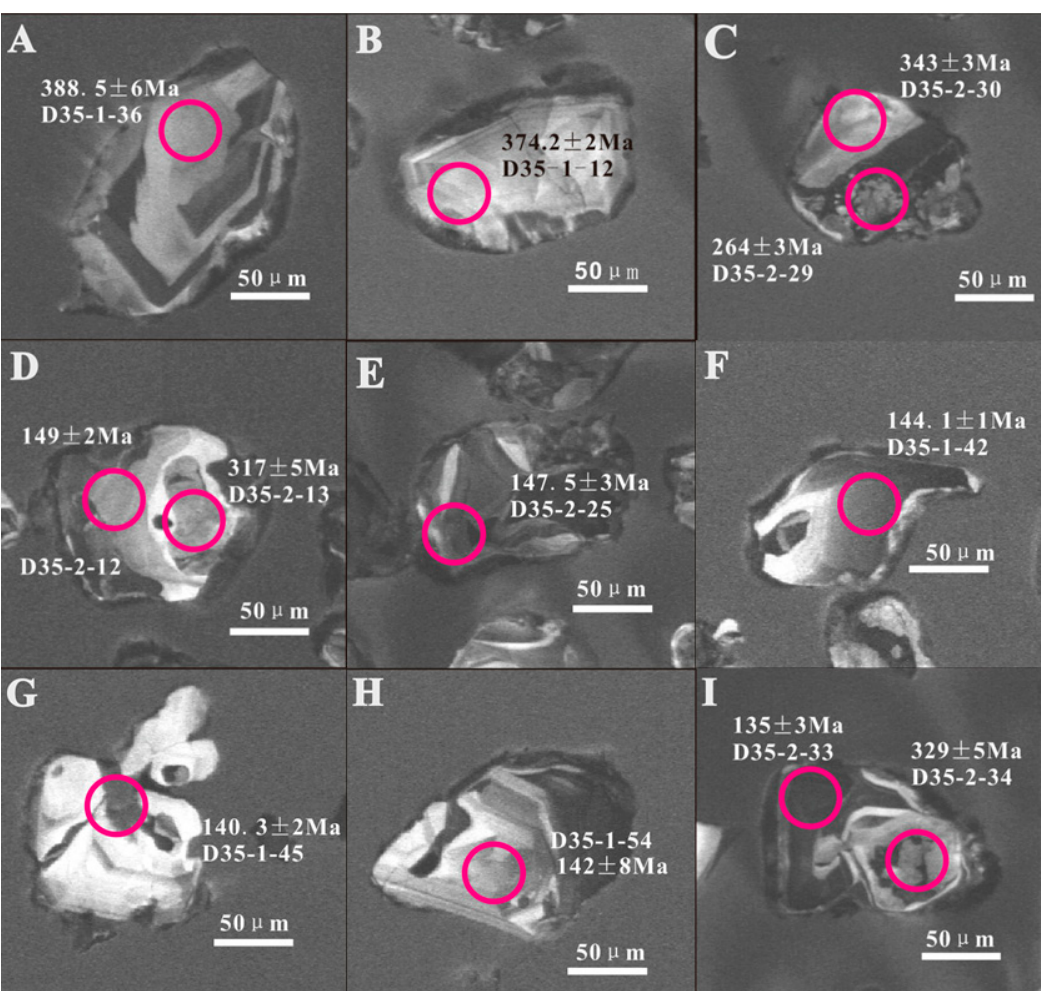
Figure 5. The measurement points on the cathodeluminescence (CL) images of zircon in porphyritic granite. ( A ) Oscillating ring zone of magmatic zircon; ( B ) weak oscillating ring zone of magmatic zircon with dark altered edge; ( C ) bright residual of magmatic zircon with rough surface below; ( D ) the magmatic zircon is transformed by the hydrothermal liquid, showing hydrothermal zircon (149 Ma) on the edge and residual of magmatic zircon (317 Ma) in the center; ( E ) dark hydrothermal zircon; ( F ) dark hydrothermal zircon with bright residual of magmatic zircon; ( G ) dark hydrothermal zircon filling along crack of magmatic zircon; ( H ) the magmatic zircon is transformed by the hydrothermal liquid, showing hydrothermal zircon in the center (142 Ma) and weak oscillating ring zone of magmatic zircon on the edge; ( I ) the magmatic zircon is transformed by the hydrothermal liquid, showing hydrothermal zircon on the edge (135 Ma) and residual of magmatic zircon (329 Ma) in the center.